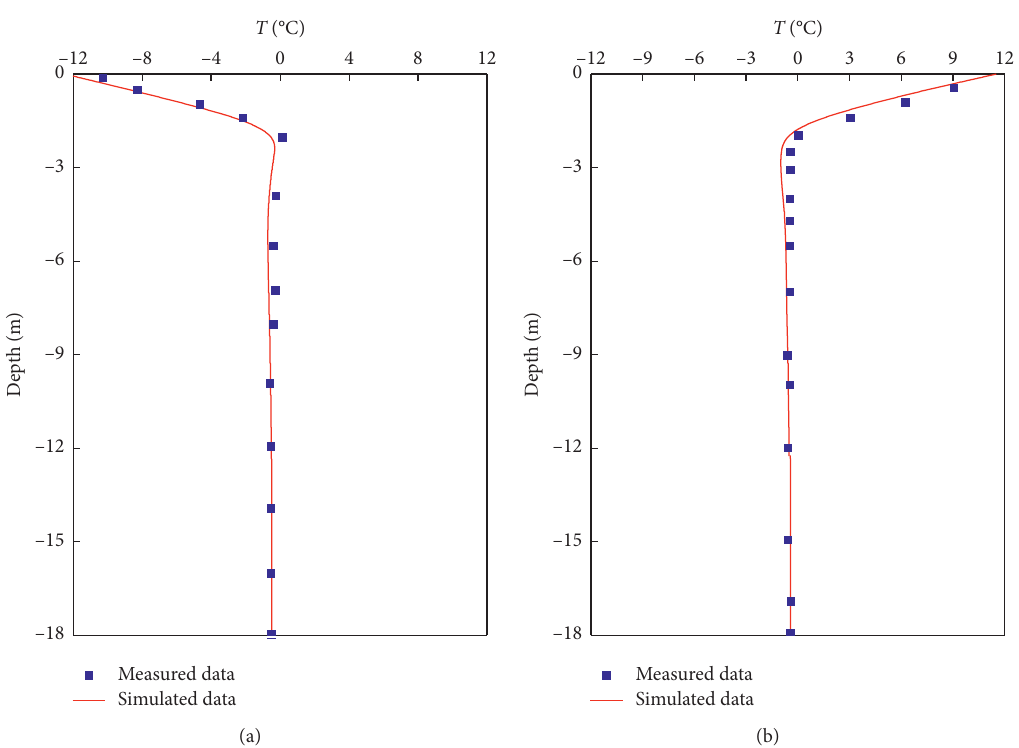
Figure 4: Field measured and numerically simulated ground temperatures vs. depth at 40cm sandy surface on (a) April 15 and (b) July